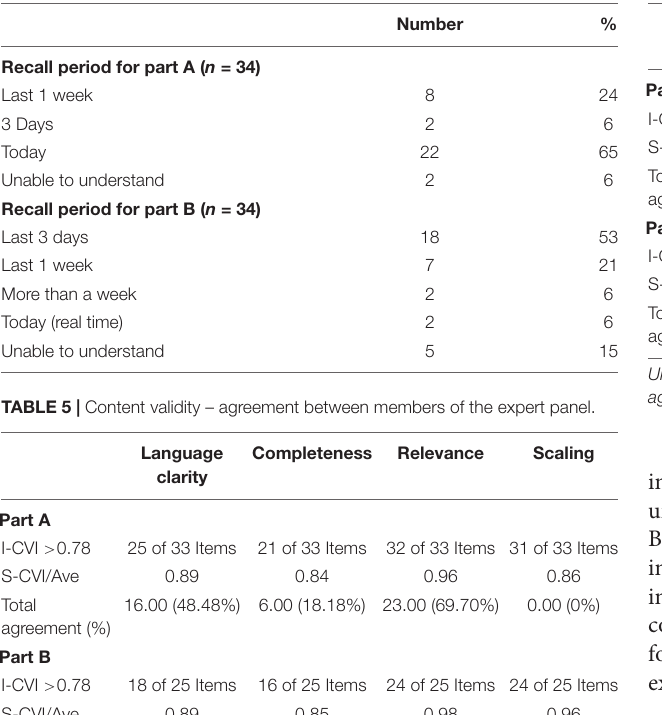
TABLE 6 | Content validity – agreement between members of the patient